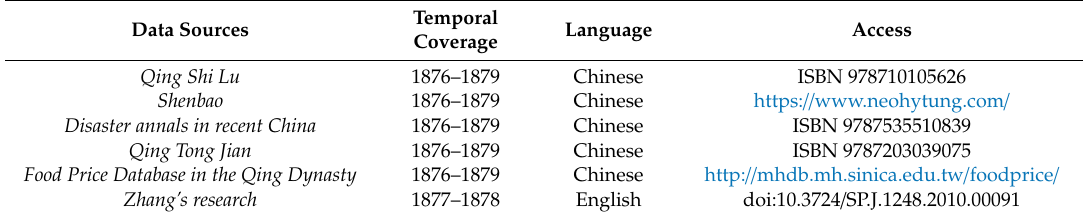
Table 1. Information on sources of the data about the North China Famine of